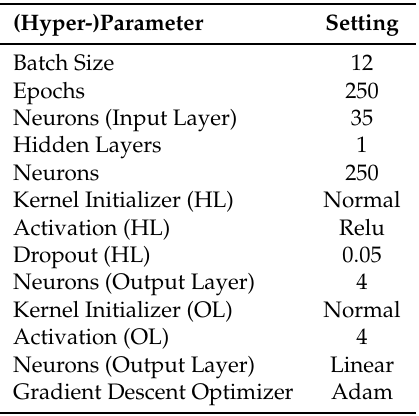
Table A3. Default neural net setting.